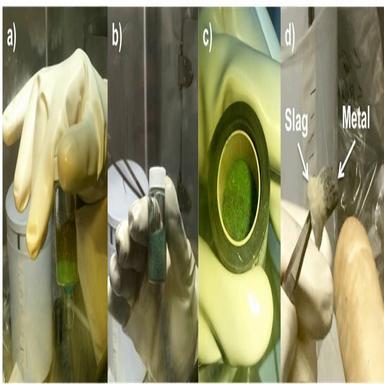
a) Reactants (Ca metal, UF4, and I2) prior to mixing, b) reactants after mixing, c) reactants in crucible/vessel, and d) image of products showing the slag and metal which were subsequently separated and analyzed.